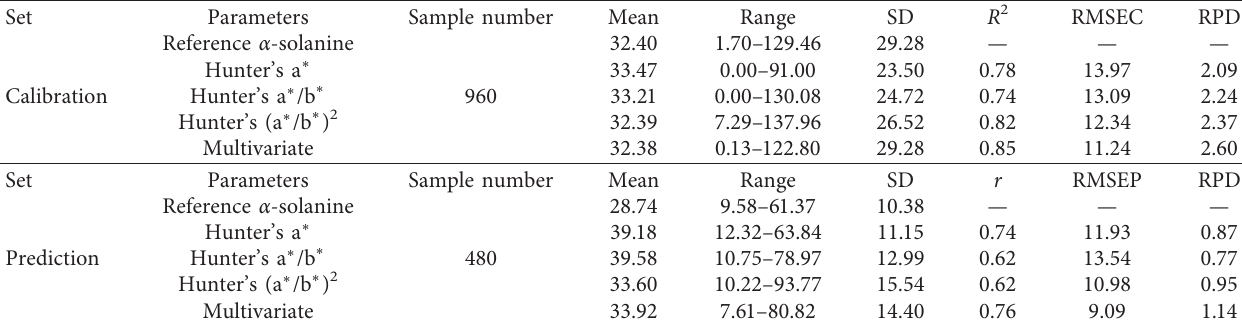
Table 2: Statistics for calibration and prediction of α -chaconine (mg kg − 1 ) using potato tubers color